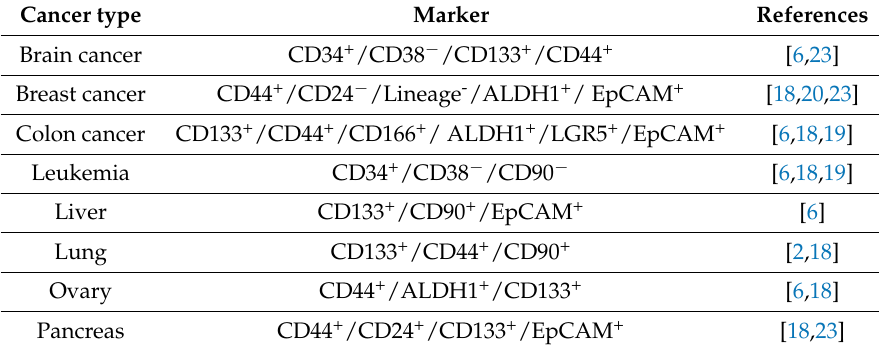
Table 1. Markers of CSCs in various tissues.